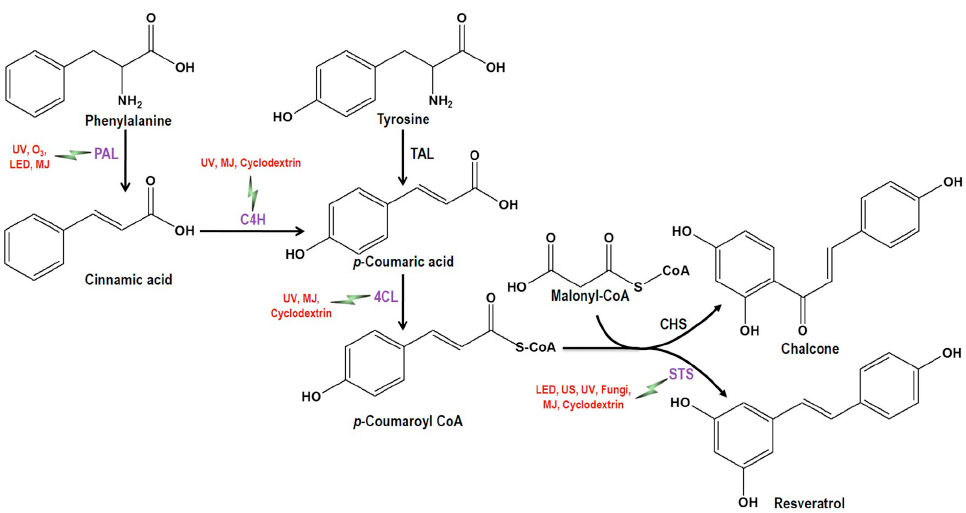
Figure 1. Biosynthesis pathway to resveratrol with enzymes involved and factors eliciting or inducing resveratrol synthesis (the symbol indicates the induction of the corresponding enzymes by the mentioned elicitors or inducer). PAL , Phenylalanine ammonia lyase; C4H , Cinnamate-4-hydroxylase; 4CL , Coumaroyl-CoA ligase; TAL, Tyrosine ammonia-lyase; CHS, Chalcone synthase; STS , Stilbene